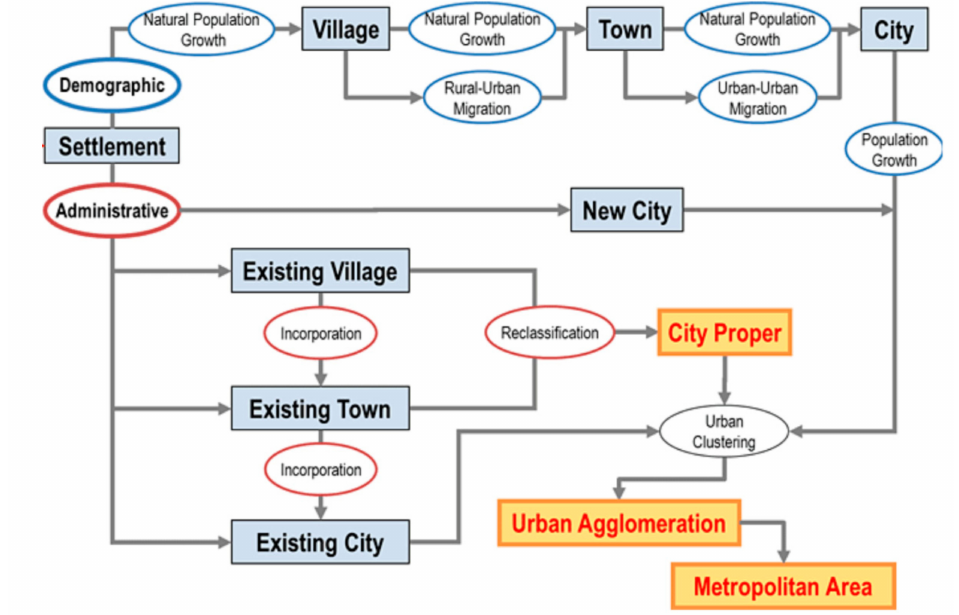
Figure 1. Selected mechanisms of urban growth based on population dynamics according to the World Urbanization Prospects (https: // population.un.org / wup / General /